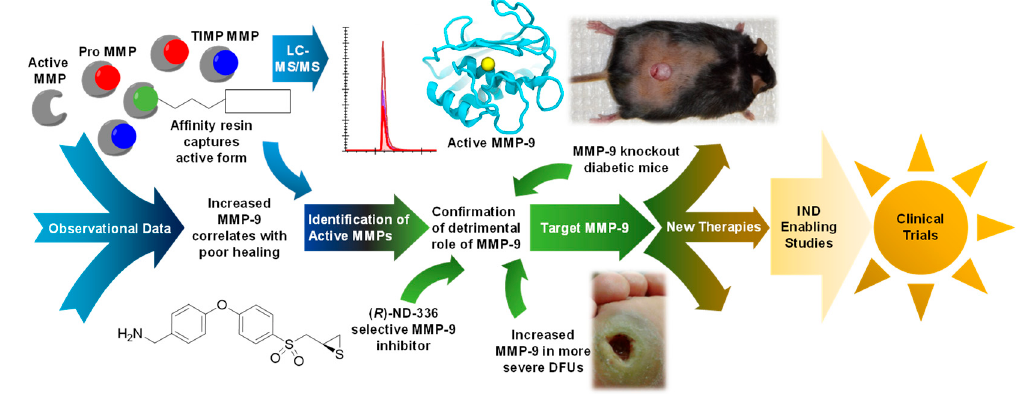
Figure 10. Schematic showing the progress of translational work to bring a selective MMP-9 inhibitor towards the clinic for treatment of DFUs.